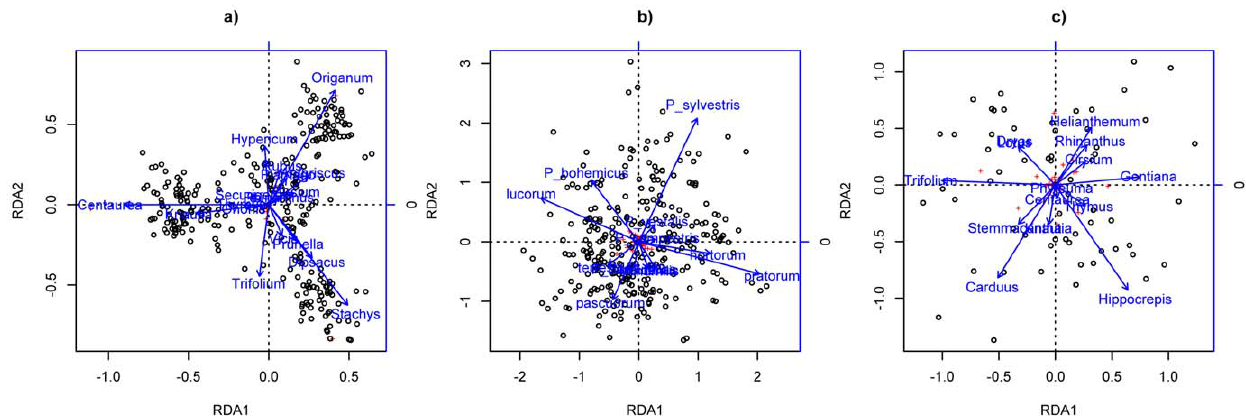
Figure 4. RDA (redundancy analysis) scatter plots for a) C.bombi flower visits constrained by host identity in the Basler Jura, controlled for the factor alleles (partial RDA, ANOVA F=5.167, p=0.005), b) C.bombi genotype segregation constrained by host identity in the Basler Jura, controlled for the factor flower visits (partial RDA, ANOVA F=1.300, p=0.005), and c) segregation of C. bombi genotypes constrained by flower visits in the Lower Engadin, controlled for the factor host identity (partial RDA, ANOVA F=1.604, p=0.005). The two axes illustrate the two principal components of the residuals of the multiple linear regression of X unto Y. The blue arrows designate the vectors for the constraining variable.